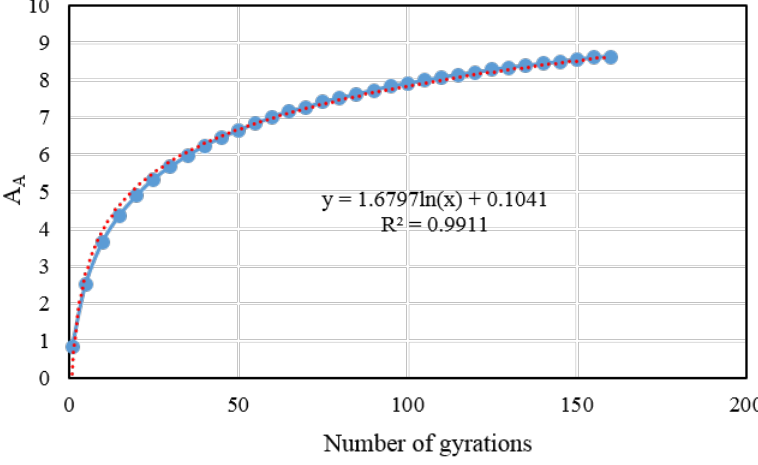
Figure 4. Relation between the accumulated area and the number of gyrations.